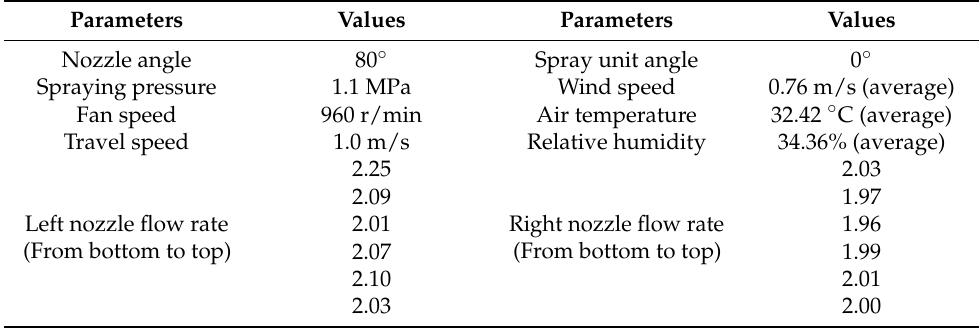
Table 2. The key parameters of the experiment.